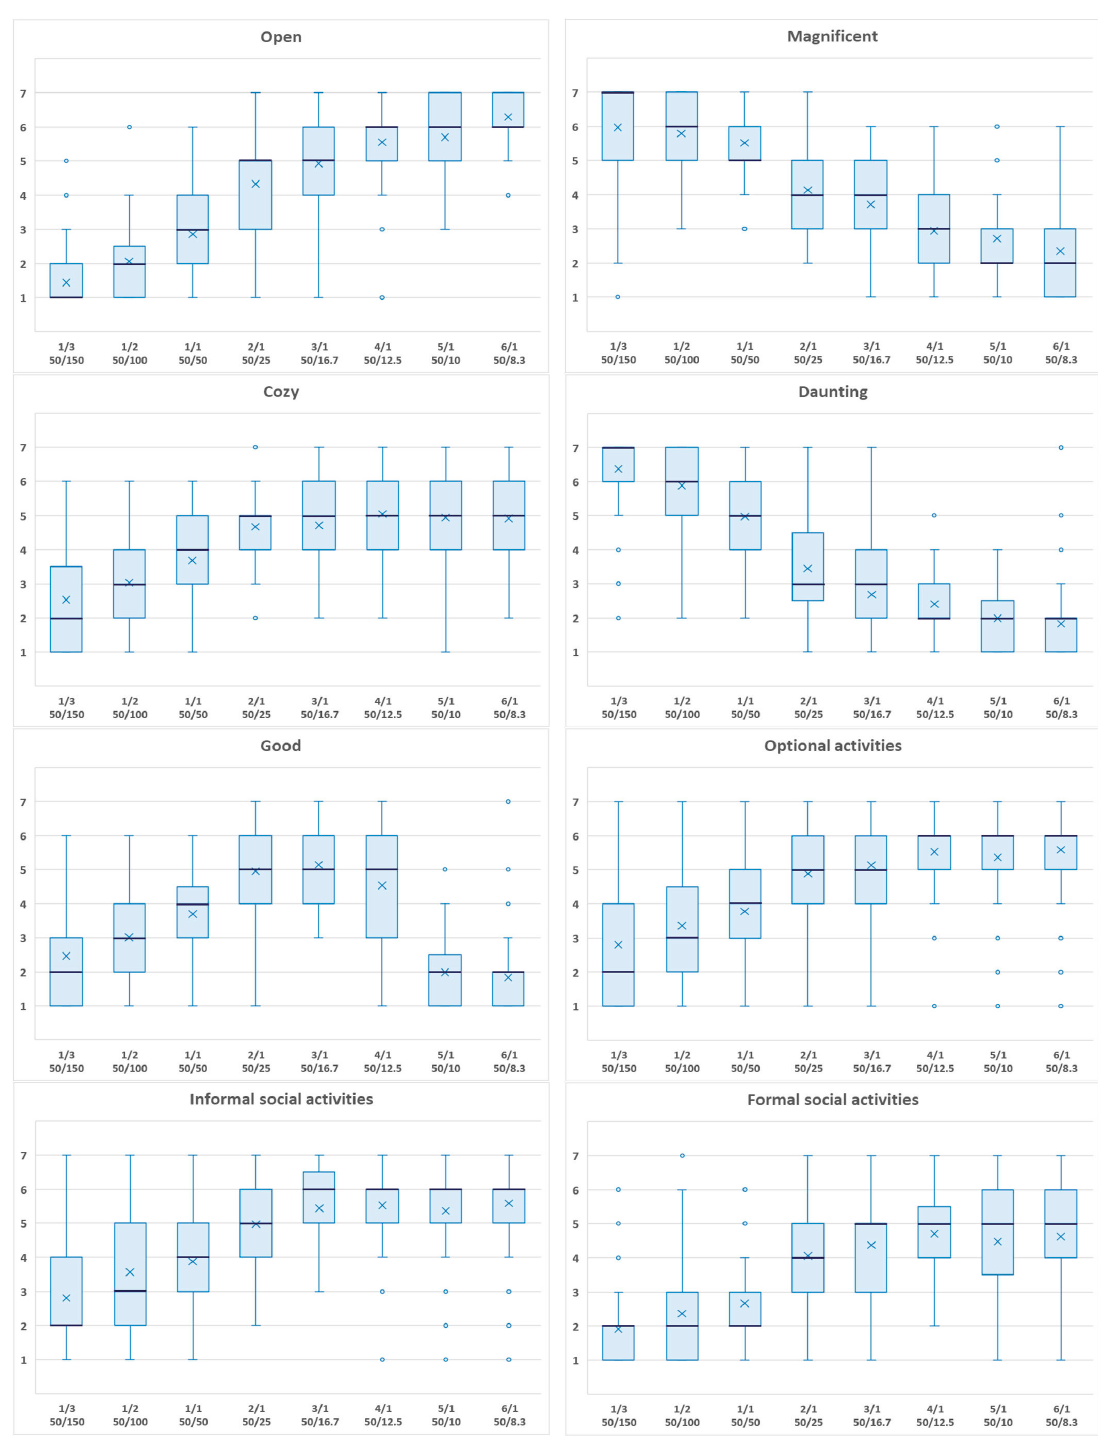
Figure 3. Box-and-whisker plots of the scores for eight dependent variables by D/H ratio.